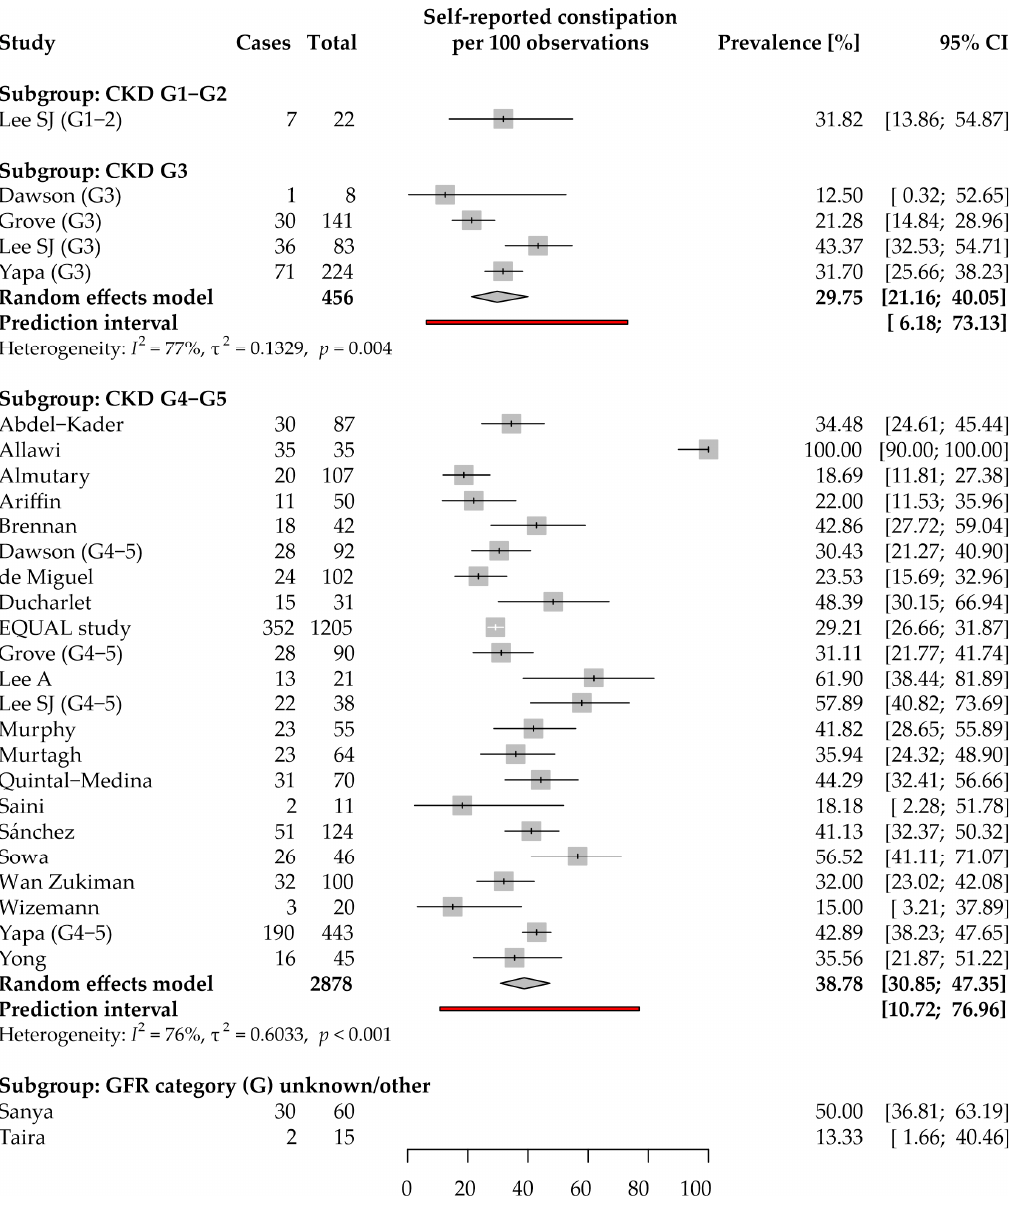
Figure 2. Forest plot with pooled point prevalence estimates for self ‐ reported constipation in chronic kidney disease by stages.